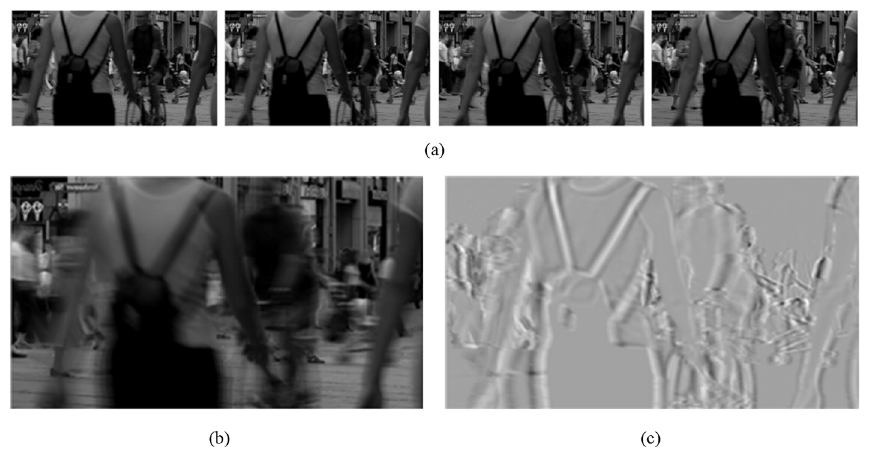
Fig 3. The original framesand the corresponding results of MCTF of the first GoF in video “Pedestrian Area” form the LIVE database. (a) 1 st GoF in “Pedestrian Area”. (b) Temporal Low-pass component.(c) Temporal High-pass